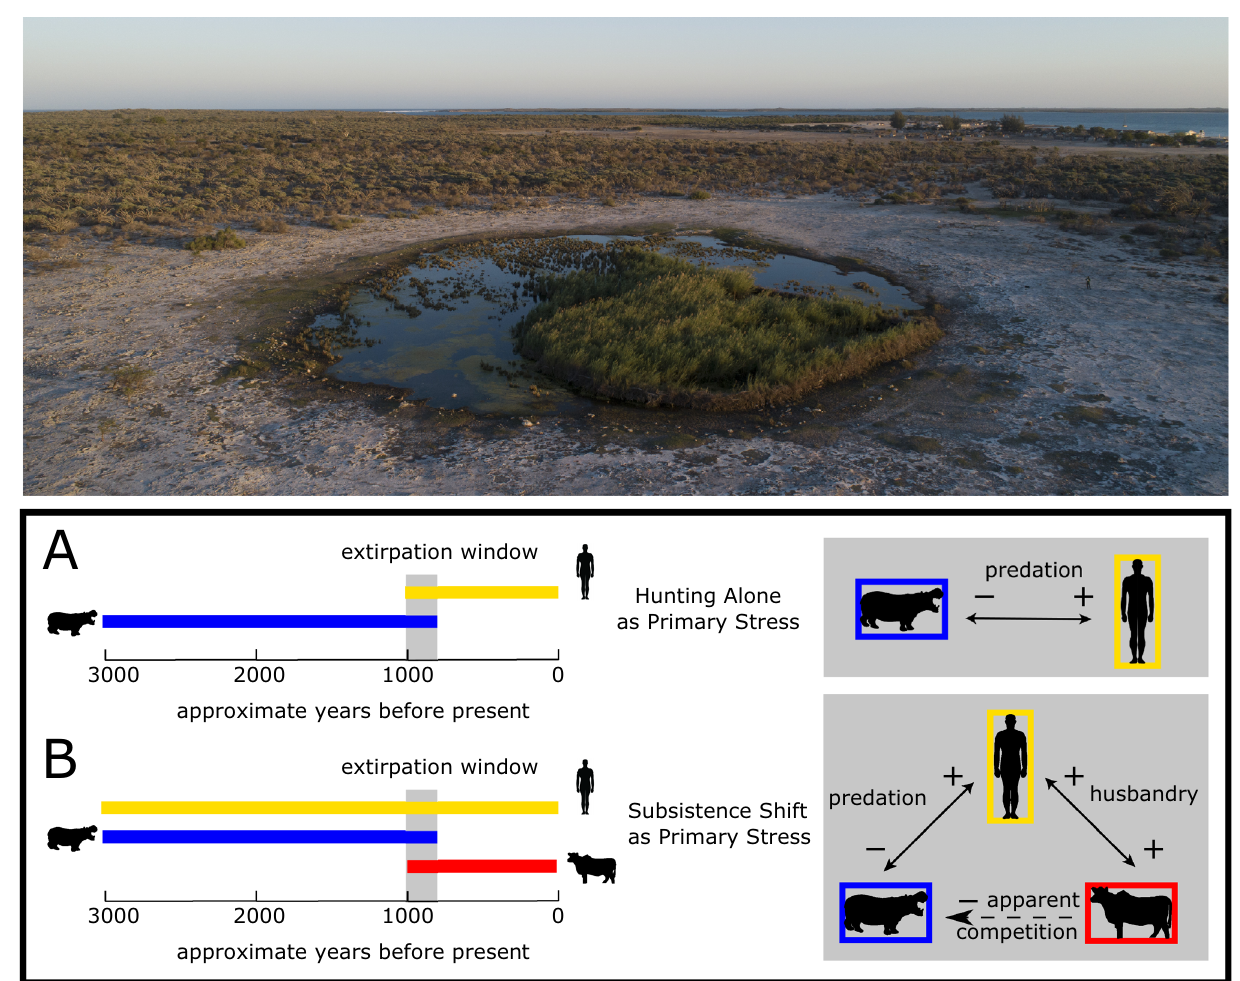
Figure 2. Drone photo of excavated pond TAMP near Tampolove, and possible chronologies underlying two conceptual scenarios ( A and B ) for human contributions to megafaunal decline. Freshwater ponds such as Tampolove are points of attraction for animals in arid SW Madagascar, and their sediments include bones that span recent millennia. If humans directly contributed to megafaunal extirpation through hunting ( A ), then we expect the local disappearance of megafaunal bone to coincide with the earliest traces of human activity. If a shift in human food production contributed to extirpation ( B ), then we expect the disappearance of megafaunal bone to coincide instead with traces of this past shift and not necessarily with the earliest traces of local human